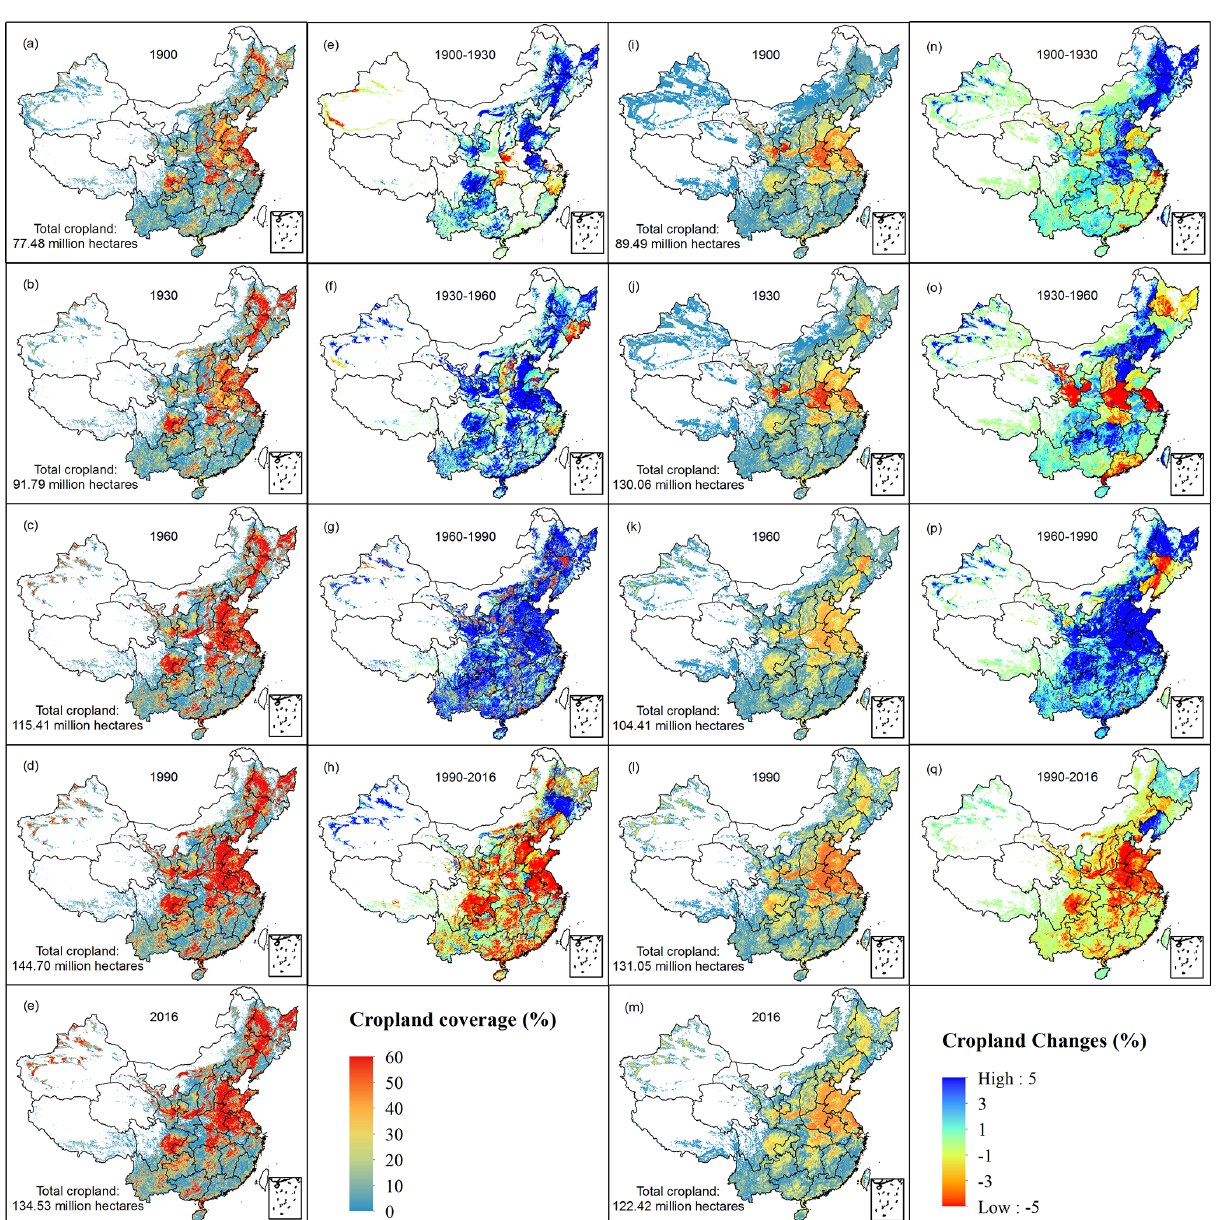
Figure 4. Cropland coverage and changes during different periods in China (left two columns) and HYDE (right two columns), excluding Taiwan, Hong Kong, Macaw, and the islands in the South China Sea; panels (a) – (e) and (i) – (m) indicate 1900, 1930, 1960, 1990, and 2016 (from top to bottom),